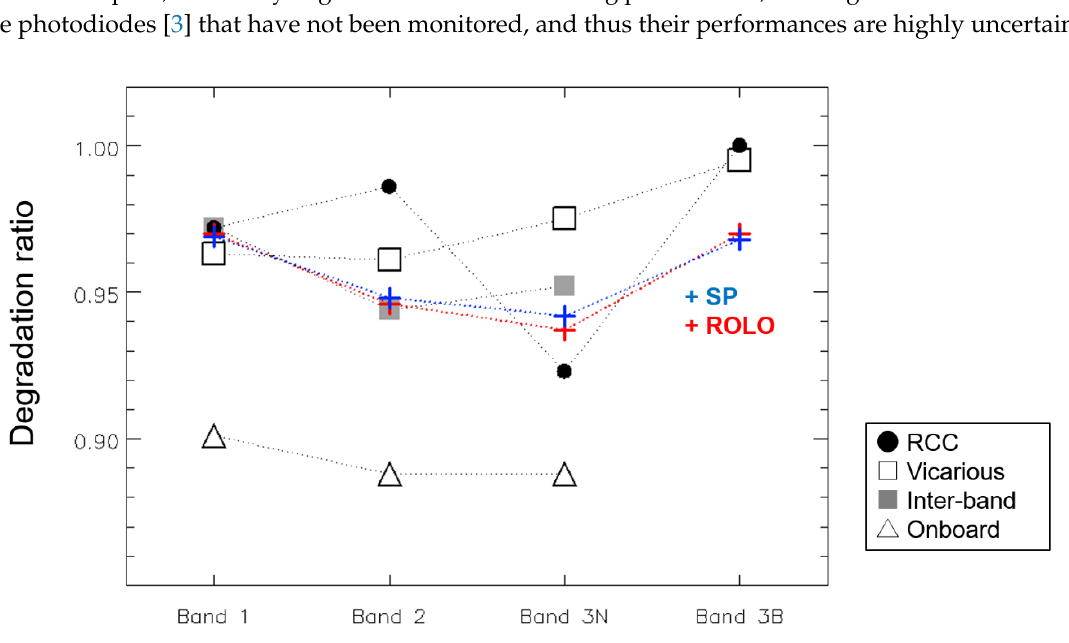
Figure 9. Comparison of the sensor sensitivity degradations in the VNIR bands from 2003 to 2017 measured from the onboard calibration (triangles), the vicarious calibration (white rectangles), and the lunar calibration (SP and ROLO models, crosses). The degradations measured from the inter-band calibration and the current RCC (version 4) are also shown (gray rectangles and black circles, respectively).